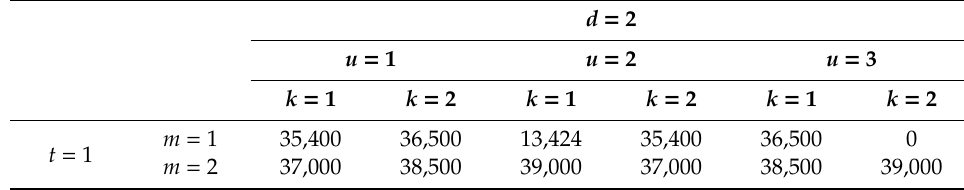
Table 22. Quantity of surgical instruments supplied by manufacturers to distributor “ d = 2” in period t = 1.